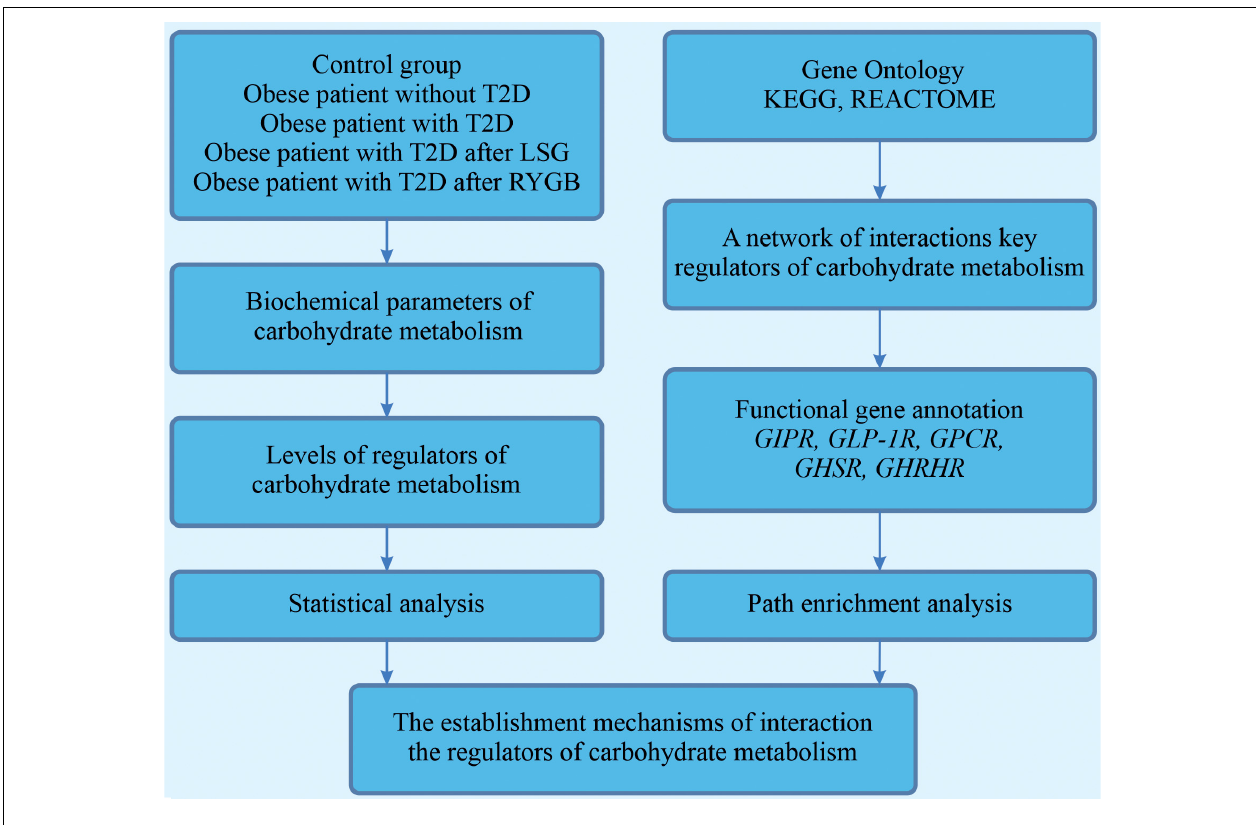
FIGURE 1 | A block-diagram of the